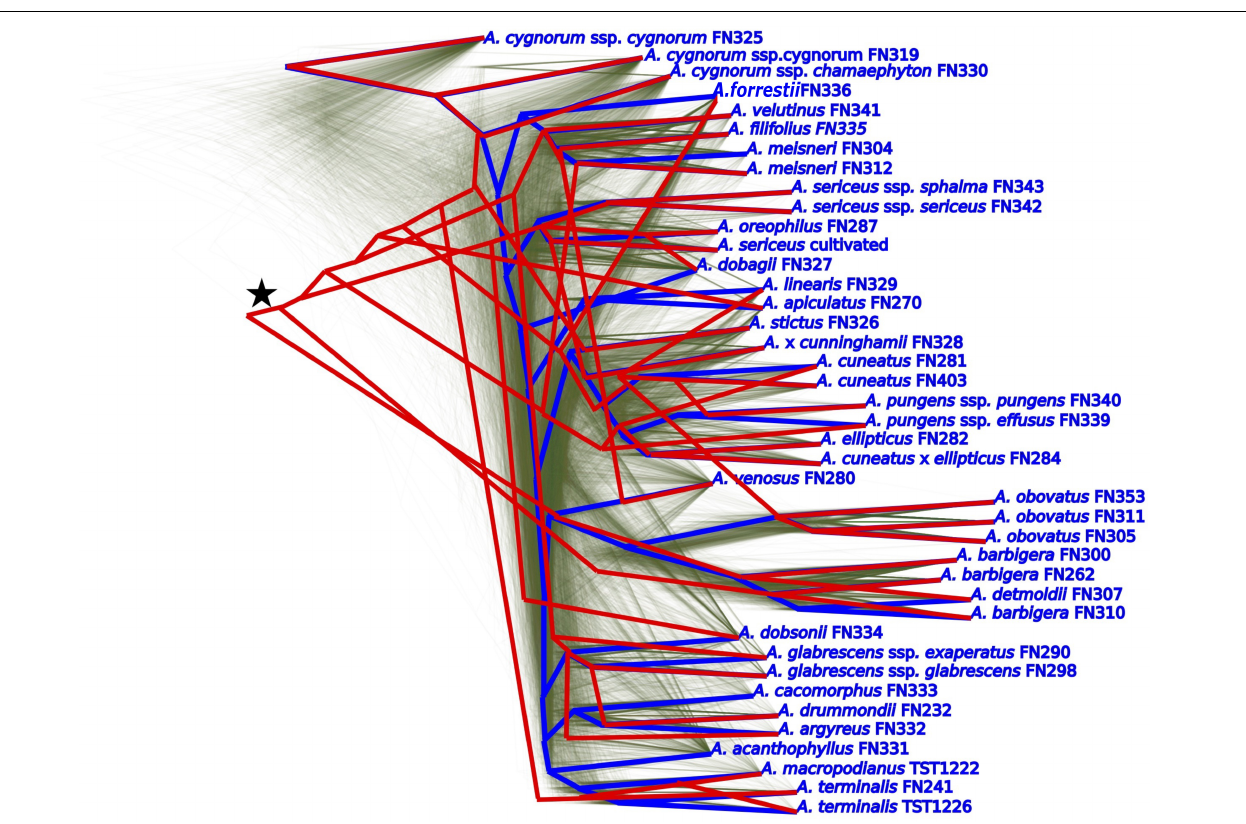
FIGURE 5 | Severe incongruence between observed empirical plastid topology (red, marked with a star) and simulated plastid consensus tree (blue) with incomplete lineage sorting but no introgression – simulated from ASTRAL nuclear species tree, with a branch scaling factor of 4. The distribution of simulated plastid trees are indicated by thin green lines drawn in